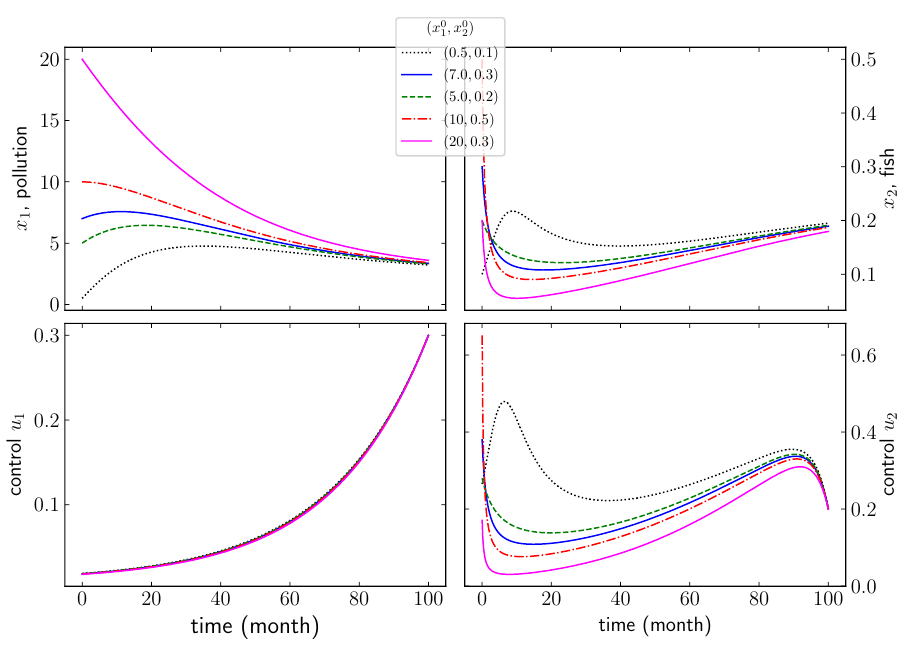
q “ 1 : one terminal condition for the control ` 1 x 1 1 q . , x 0 2 1